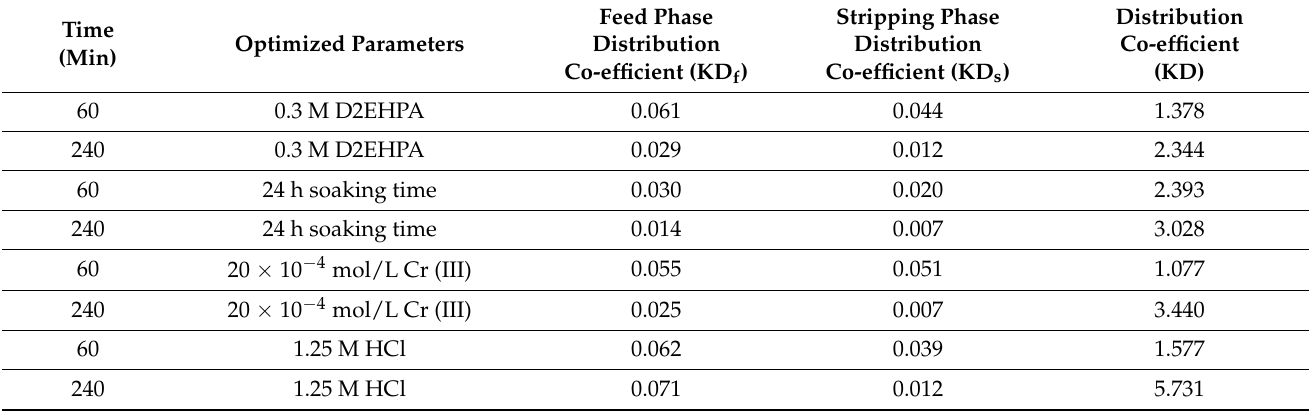
Table 2. Distribution coefficient (KD) at the 60th and 240th minutes of the experiment.